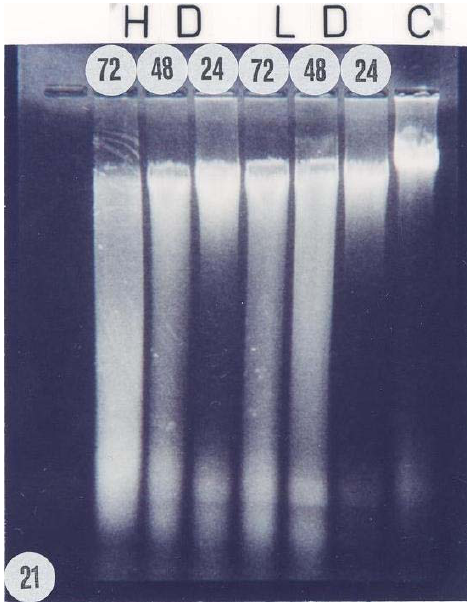
Figure 21 . Gel electrophoresis showing isolated genomic DNA of the brain in control and envenomed samples. C: Control; 24L, 48L, 72L: Samples 24, 48, and 72 hr after low dose (LD) envenoming; 24H, 48H, 72H: Samples 24, 48, and 72 hr after high dose (HD) envenoming. Note DNA fragmentation in sample from envenomed